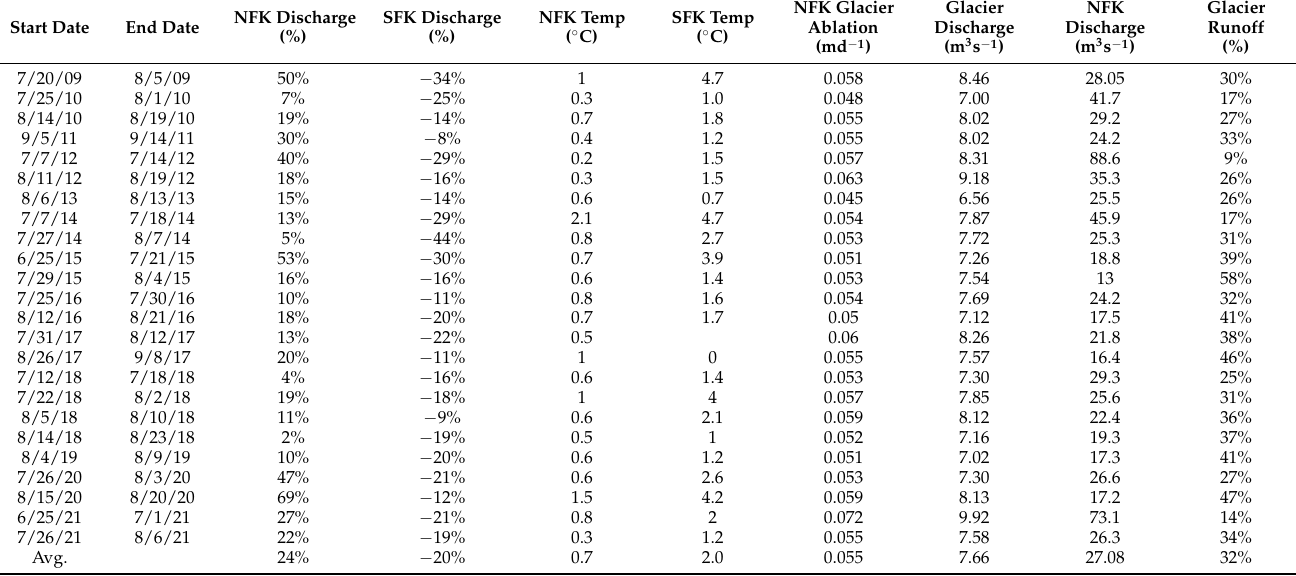
Table 3. Impact of 24 heat events on North Fork Nooksack (NFN) and South Fork Nooksack discharge and temperature, glacier ablation, glacier runoff, and overall glacier contribution to flow of